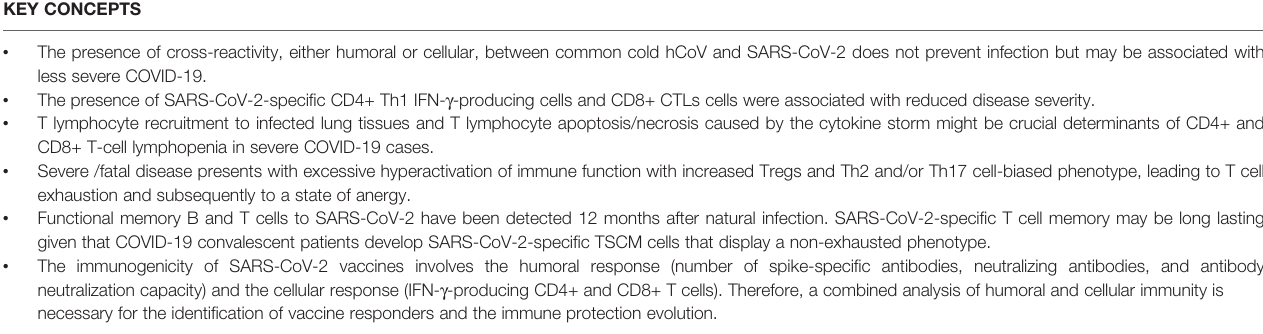
TABLE 1 | Up-to-date key concepts to consider regarding natural infection or vaccination immunity against